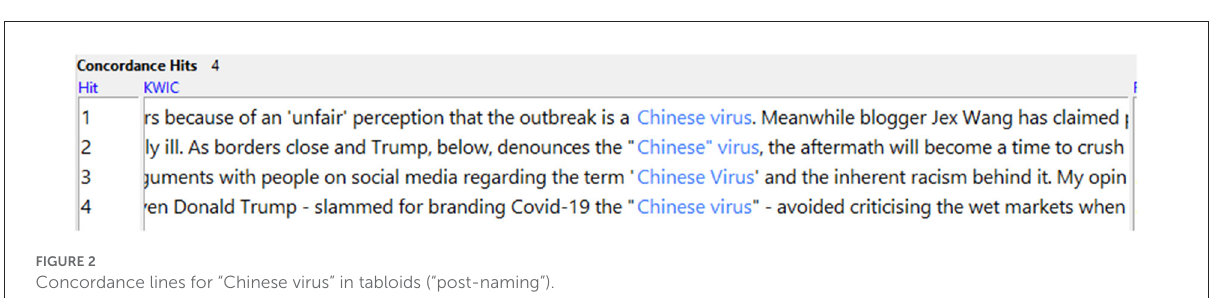
FIGURE2 Concordance lines for “Chinese virus” in tabloids